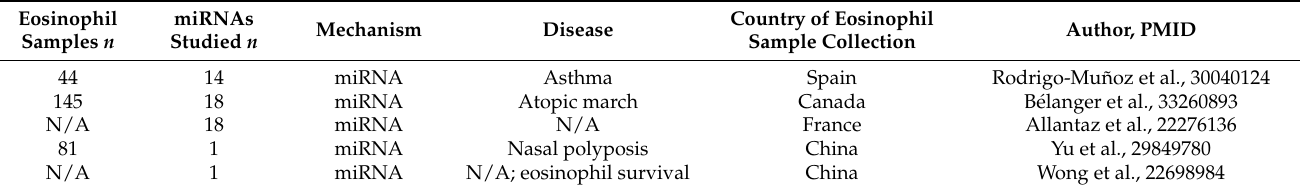
Table 3. miRNA studies of